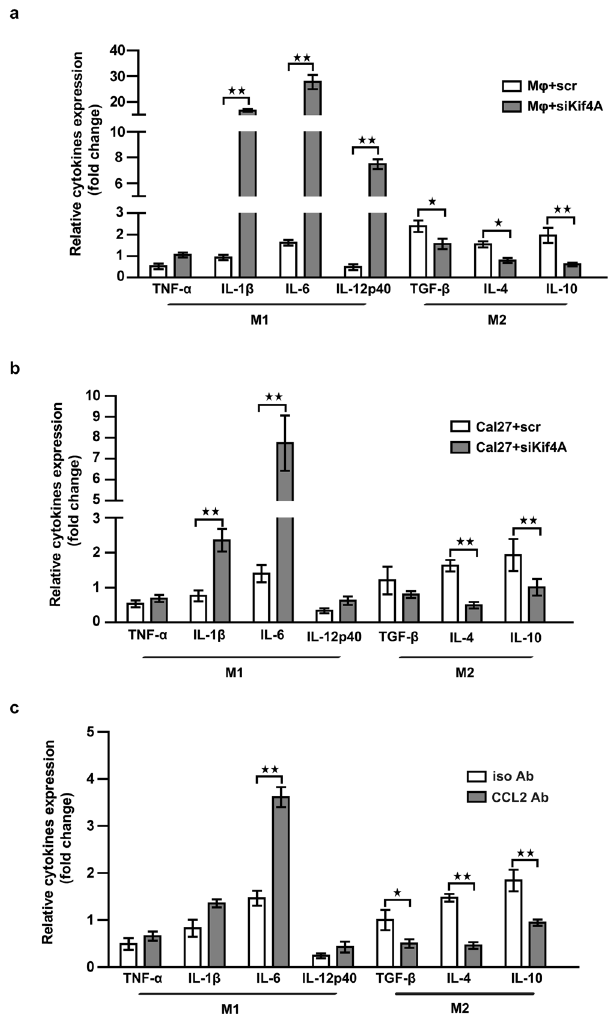
Figure 4. Kif4A-CCL2 modulated macrophages function. The transcription of typical pro-inflammatory or anti-inflammatory cytokines of THP-1-derived macrophages was measured by RTQ-PCR. ( a ) THP- 1-derived macrophages were transfected by scr or siKif4A, and then co-cultured with Cal-27 for 24 h. ( b ) Cal-27 was transfected by scr or siKif4A, and then co-cultured with THP-1-derived macrophages for 24 h. ( c ) CCL2 neutralizing antibody or isotype antibodies (10 μ g/mL) was added into supernatant of co-culture system for 24 h. Relative gene expression was normalized to the expression of GAPDH mRNA and expressed as fold change for each relative gene reaction among the samples. Each bar represents the mean ± SEM (n = 5, * p < 0.05, ** p <